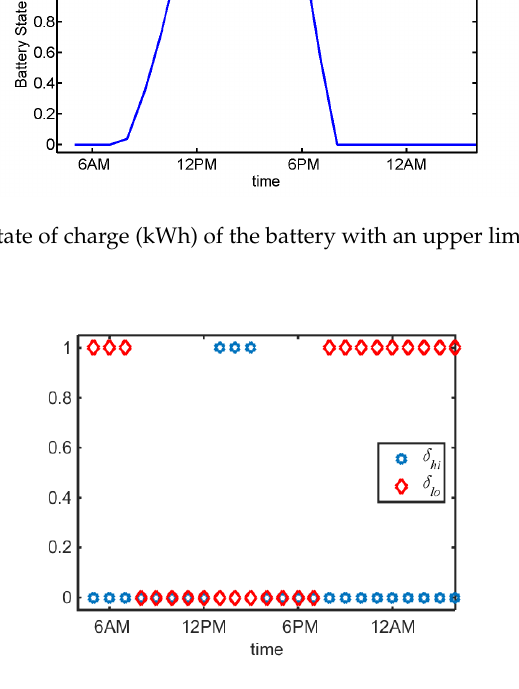
Figure 13. Pseudo-binary variables indicating a fully charged battery ( δ hi ) and a fully discharged battery ( δ lo